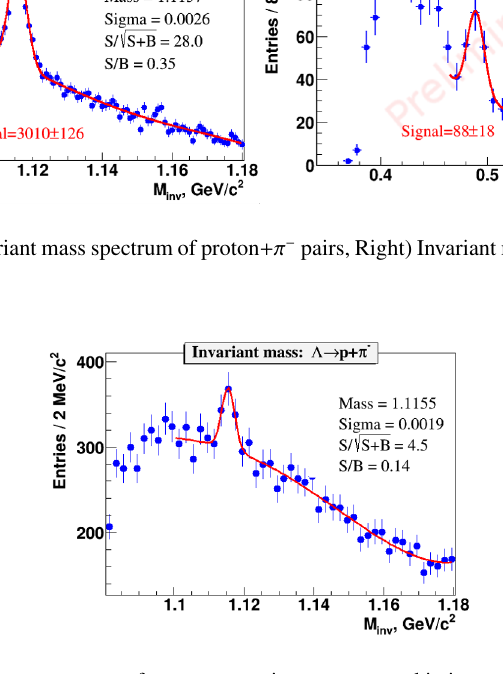
Figure 11. Invariant mass spectrum of proton + π − pairs reconstructed in interactions of the argon beam with